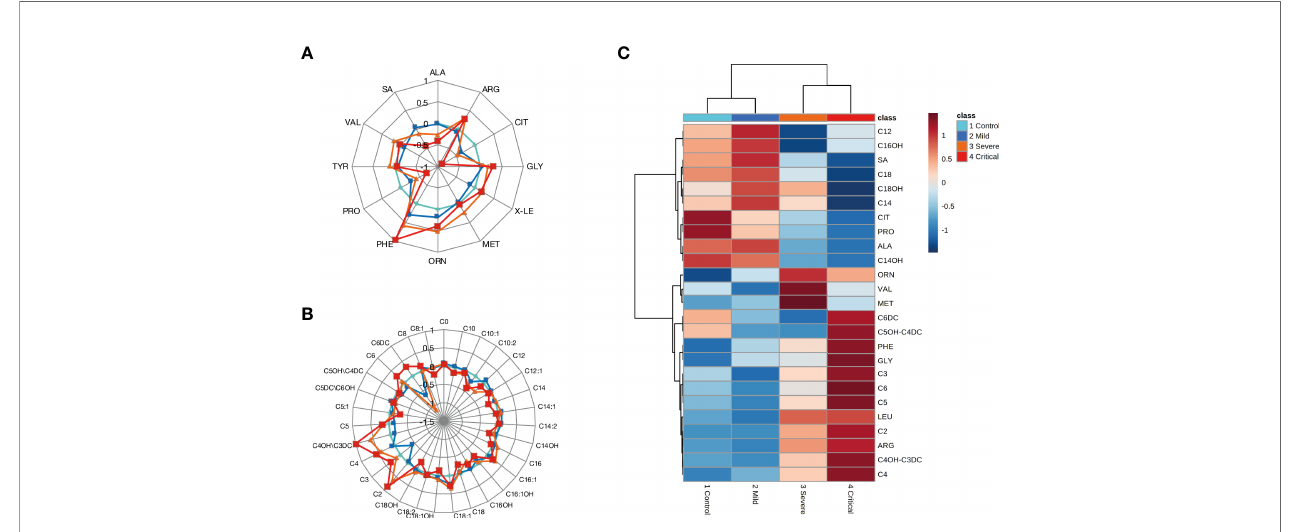
FIGURE 1 | Changes associated with COVID-19 clinical severity. (A) Radar plot of amino acid and SA pro fi les in the studied groups. (B) Radar plot of acylcarnitine pro fi les in the studied groups. The log2-normalized median fold-change in the levels of acylcarnitines was calculated and compared with the levels in HS. (C) Hierarchical clustering analysis heatmap illustrating the changes in serum metabolite abundance (average serum metabolites from each studied group) of the top 25 metabolites from HS and patients with mild, moderate, and critical COVID-19. The colored boxes on the right of the fi gure indicate the relative concentrations of the corresponding metabolite in each group under study, from less concentrated (dark blue) to most concentrated (dark red). ALA, Alanine; ARG, Arginine; CIT, Citrulline; GLY, Glycine; XLE-OHPro (Leucine, Isoleucine Alloisoleucine and Hydroxyproline); MET, Methionine; ORN, Ornithine; PHE, Phenylalanine; PRO, Proline; TYR, Tyrosine; VAL, Valine; SA, Succinylacetone; C0, Free-carnitine; C2, Acetylcarnitine; C3, Propionylcarnitine; C3DC, Malonylcarnitine; C4, Butyrylcarnitine; C4OH, 3- hydroxy-butyrylcarnitine; C4DC, Methylmalonylcarnitine; C5, Isovalerylcarnitine; C5:1, Tiglylcarnitine; C5DC, Glutarylcarnitine; C5OH,